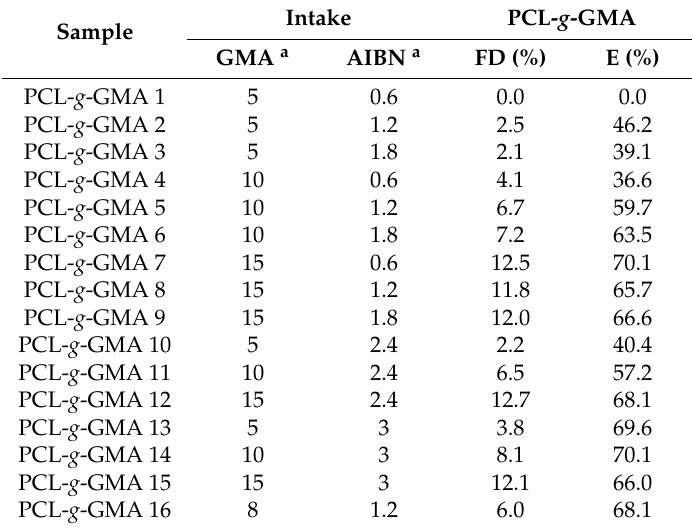
Table 1. Overview of experiments for the PCL- g -GMA (T = 97 ◦ C, P = 90 bar, t reaction = 40 min). Sample